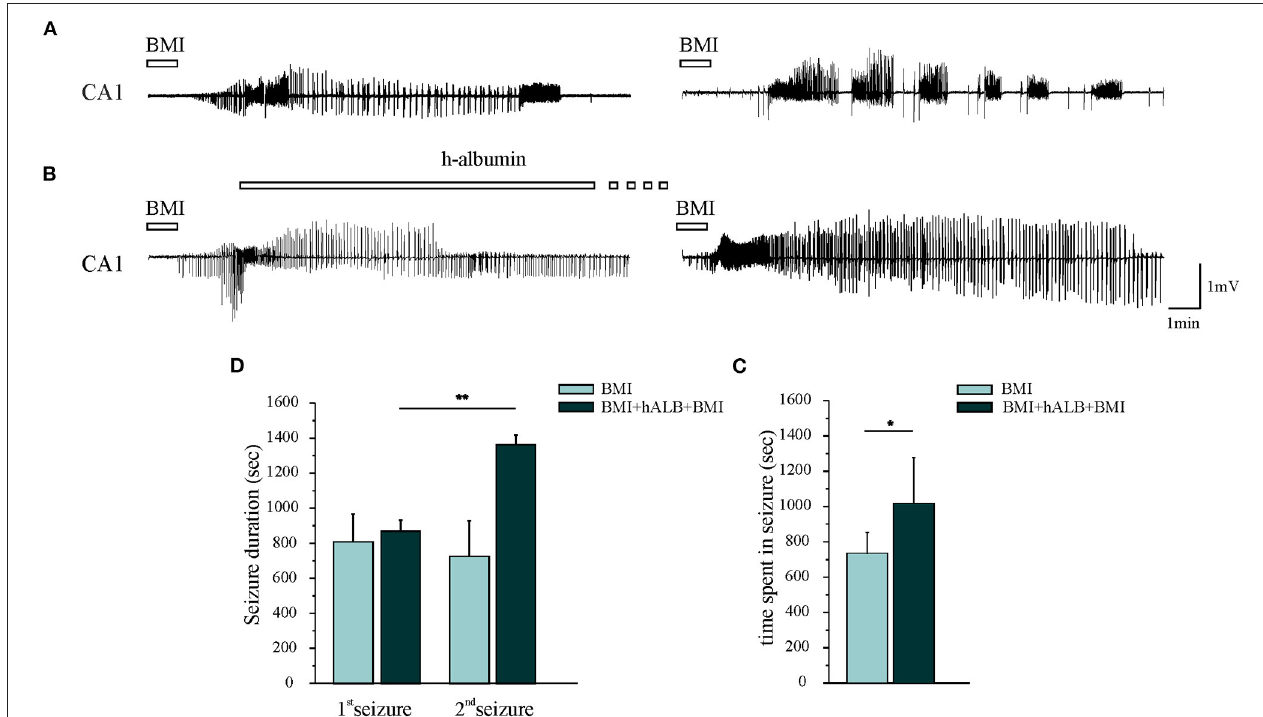
FIGURE 2 | Epileptiform discharges recorded in CA1. (A) The first and the second 3-min application of BMI induced one seizure-like event (SLE). (B) 30-min h-recombinant albumin (h-ALB) perfusion after the first BMI-induced SLE (left trace) significantly increased the duration of the second BMI-induced SLE (right trace). (C) Mean SLE durations induced by the first (1st SLE) and the second application of BMI with and without h-recombinant albumin application (2nd SLE). (D) Total time spent in seizure after the application of the experimental protocols B and C, respectively. * p < 0.05; ** p < 0.01 with Student t -test.